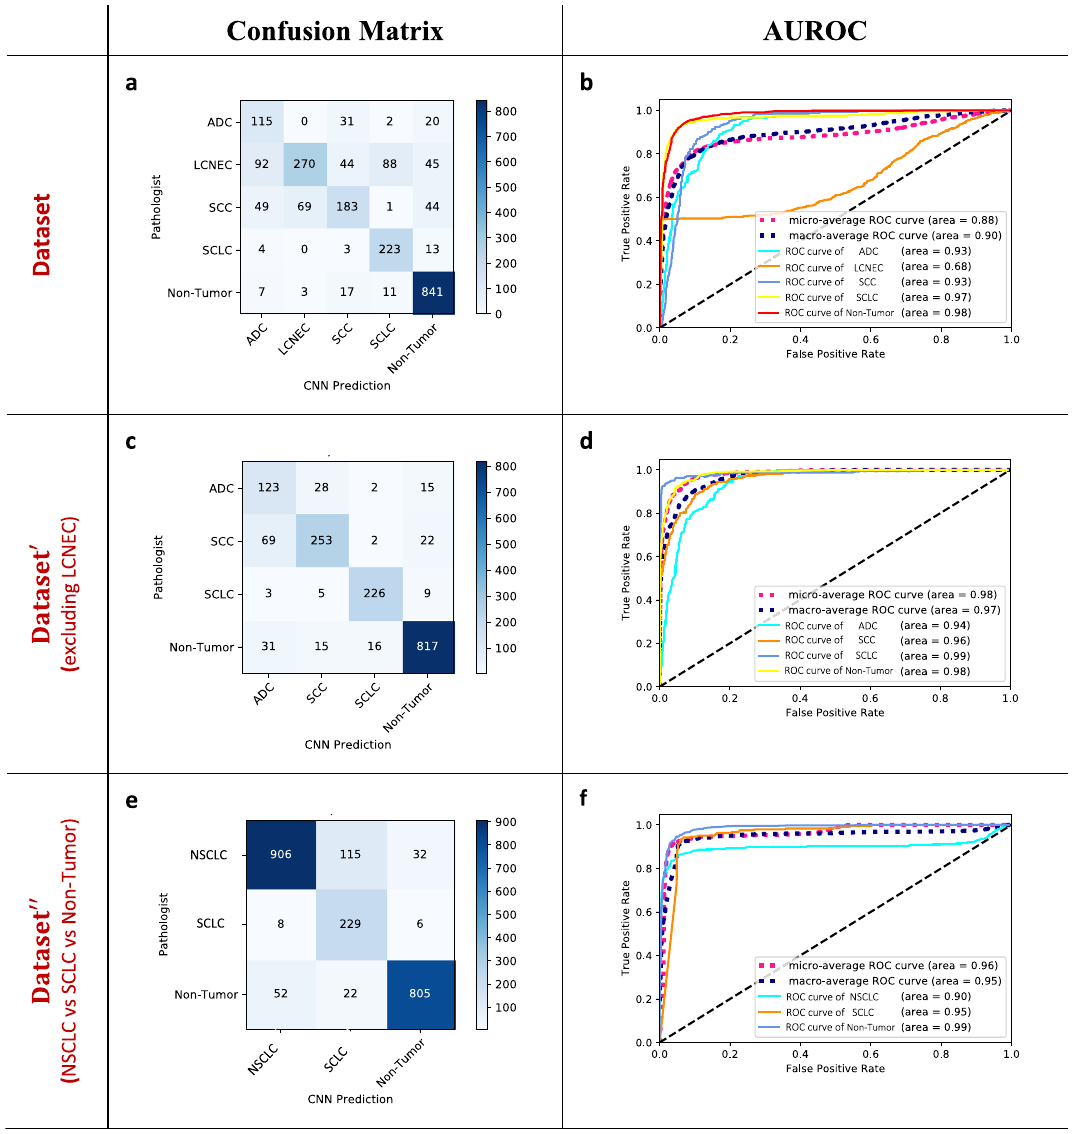
Figure 3. Confusion matrices and areas under the curve (AUC) for the receiver operating characteristic curves (ROC) achieved by the CNN from scratch on the three data sets. The diagnostic performance of the CNN model built from scratch in multinomial classification of lung cancer subtypes was evaluated on the test sets. Dataset consisted of five classes; ADC, LCNEC, SCC, SCLC, and non-tumor. Dataset ′ consisted of four classes excluding LCNEC from the dataset. Dataset ″ composed three classes with NSCLC (combining ADC, LCNEC, and SCC), SCLC, and non-tumor. The area under the curve (AUC) of receiver operating characteristic curve (ROC) achieved by the scratch CNN model on each dataset are shown [Dataset ( a , b ), Dataset ′ ( c , d ), Dataset ″ ( e , f